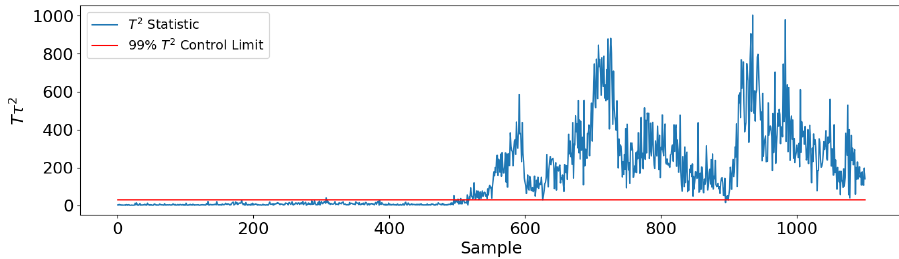
Figure 15. Monitoring results of industrial case based on cointegration analysis with ACE.